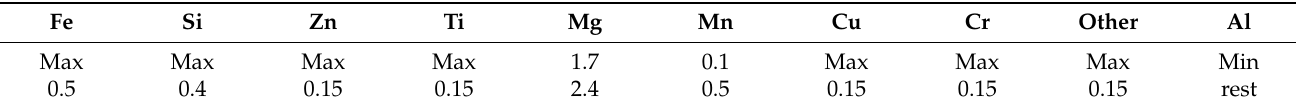
Table 1. Chemical composition of EN AW-5251 aluminum